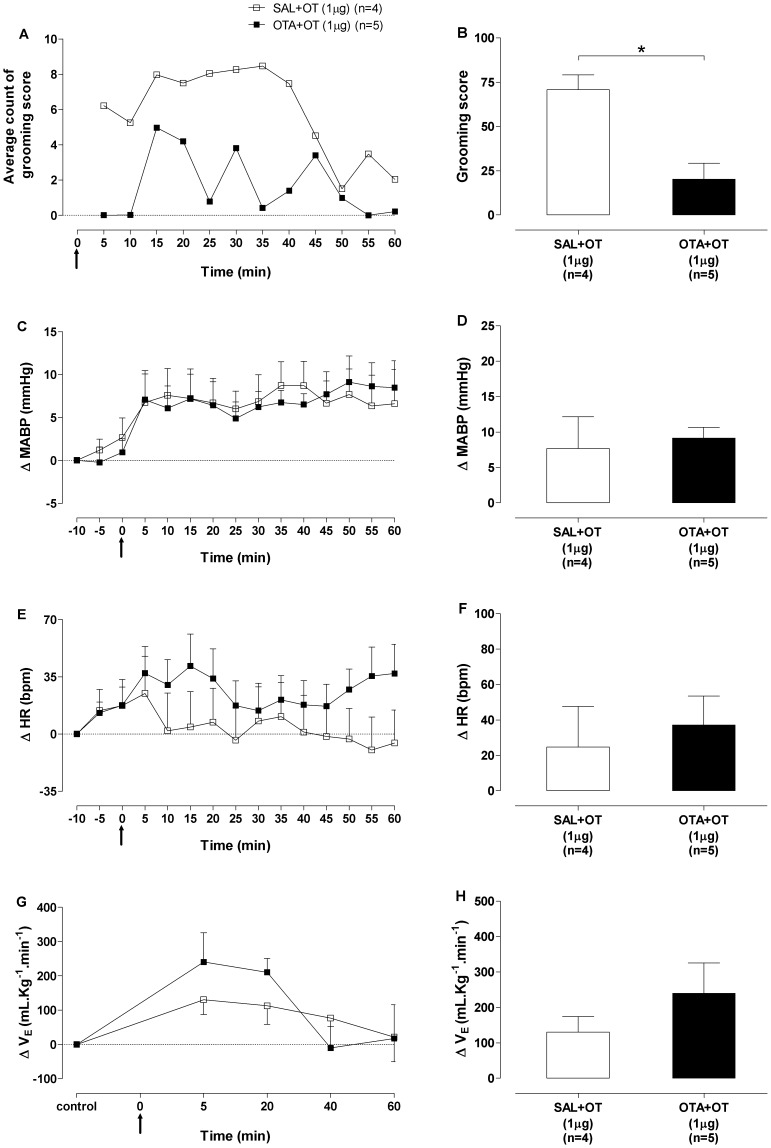
Behavioral, hemodynamic and respiratory responses to oxytocin antagonist.(A) Grooming score average count of the 5-min behavior sampling window of the saline+oxytocin (SAL+OT) 1 µg and vasotocin+OT (OTA+OT) 1 µg groups. (B) Grooming score (mean of 60 min) of the SAL+OT 1 µg (open bar) and OTA+OT 1 µg (black bar) groups. Time-course of (C) mean arterial blood pressure (ΔMABP, mmHg), (E) heart rate (ΔHR, bpm) and (G) minute ventilation (ΔVE, mL.Kg−1.min−1) changes for 60 min after bilateral microinjections of OT 1 µg into the central nucleus of amygdala (CeA) in the SAL+OT 1 µg and OTA+OT 1 µg groups. Maximum responses in (D) mean arterial blood pressure (ΔMABP, mmHg) at 50 min, (F) heart rate (ΔHR, bpm) at 5 min and (H) minute ventilation (ΔVE, mL.Kg−1.min−1) at 5 min after bilateral microinjections of OT 1 µg into the CeA in the SAL+OT 1 µg (open bars) and OTA+OT 1 µg (black bars) groups. The arrow indicates the moment of microinjections. Data shown represent the means ± standard error of mean. (*) SAL+OT 1 µg group vs VASO+OT 1 µg group; p<0.05, Poisson model.